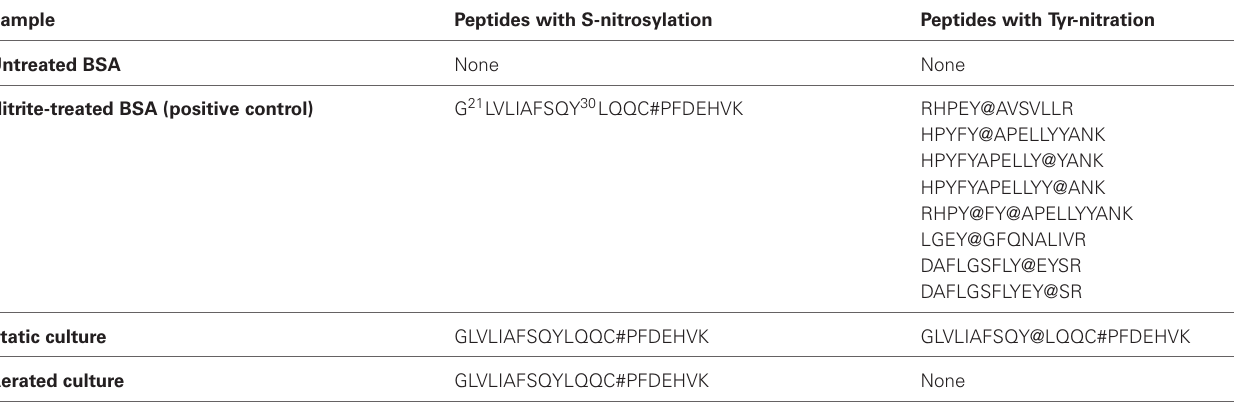
Table 1 | Chemical modifications of BSA identified in Sups of B. anthracis Sterne cultures grown in CSFM*.